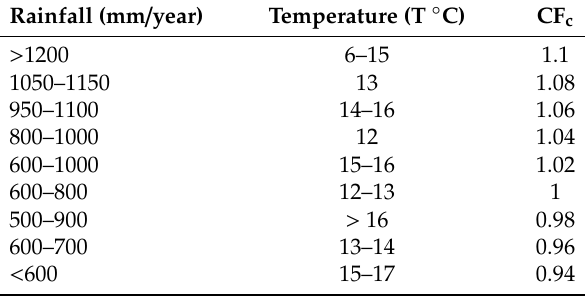
Table 3. Control classes for the climate (CF c ).